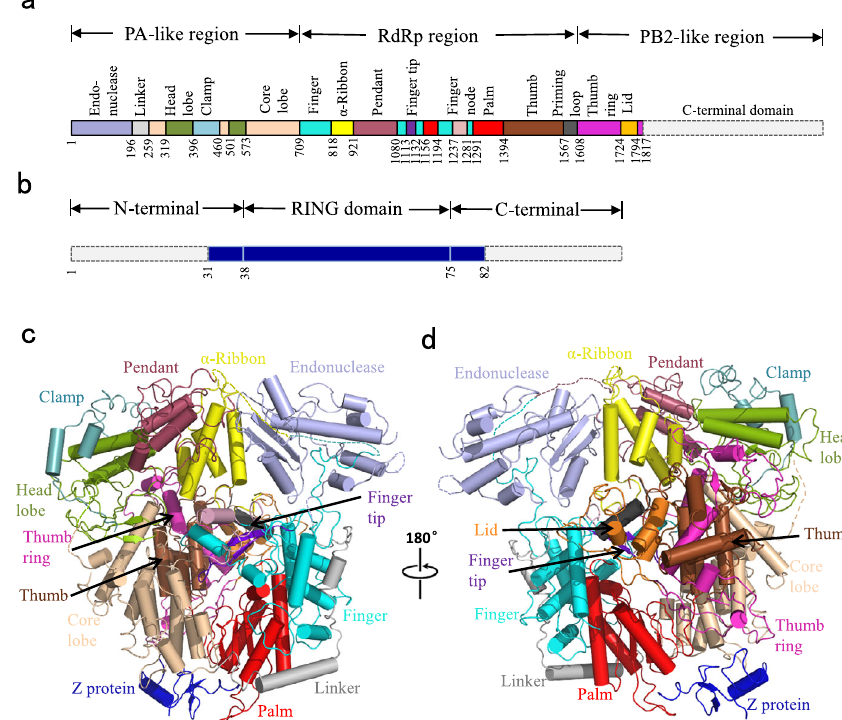
Fig. 2 Overall structure of JUNV L – Z complex. a Schematic diagram of the domain architecture of JUNV L protein divided into three parts: the PA-like region, the RdRp region and the PB2-like region. Each domain of JUNV L is represented using a unique color. The unresolved regions of L C-terminal are indicated by dotted lines. b Schematic diagram of the domain architecture of JUNV Z protein divided into three parts: the N-terminal, the middle RING domain and the C-terminal. The unresolved regions of N-terminal and C-terminal are indicated by dotted lines. c , d Cartoon representation of JUNV L – Z complex. The structures are colored by domains, the coloring scheme is identical to that in ( a , b ). The unresolved linker regions are connected by dashed lines. ( d ) Regions identical to those depicted in ( c ), but rotated 180° along the vertical